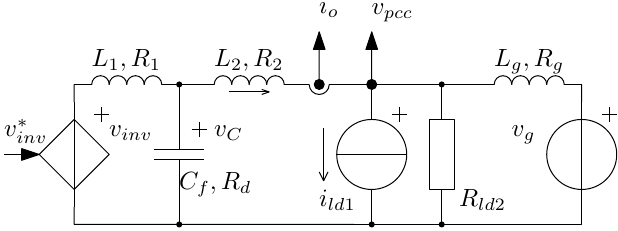
Figure 2. Simplified diagram of the grid-connected converter with local